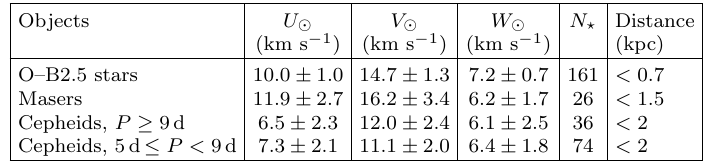
Table 1. Components of the peculiar velocity of the Sun with respect to the LSR, calculated taking into account only the differential Galactic rotation. Objects U ⊙ V ⊙ W ⊙